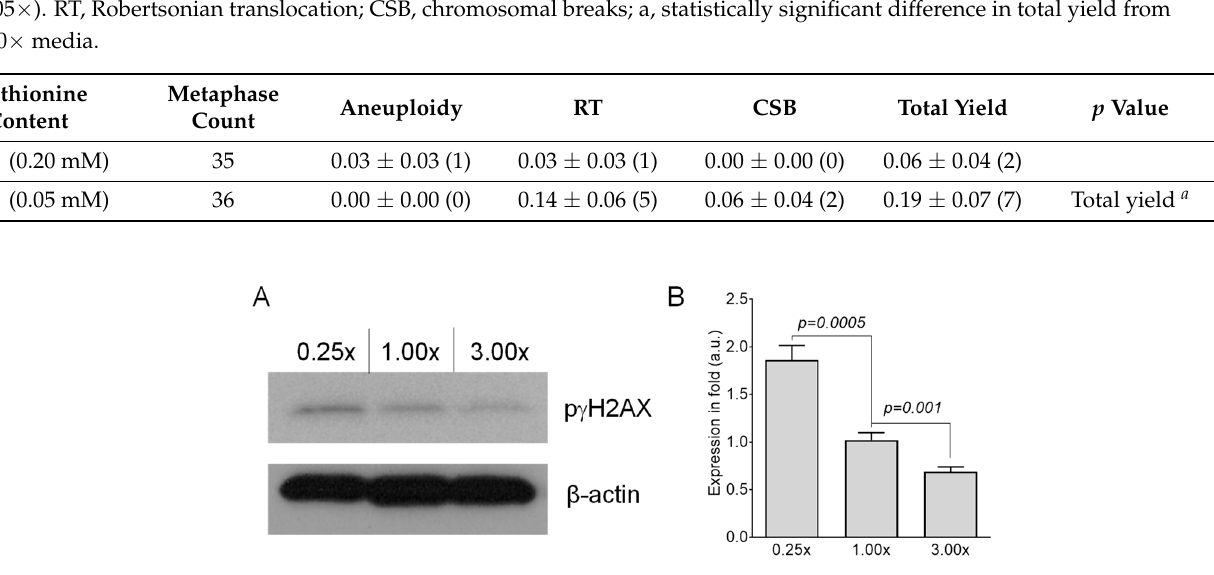
Figure 3. Effects of methionine on genetic damage. ( A ) Representative Western blot analysis and ( B ) quantitation of phosphorylated γ H2AX protein, a marker of DNA double-strand breaks, in RAW 264.7 cells grown in either methionine-deficient (0.25×) or adequate (1.00×) or supplemented (3.00×) media for 1 month ( n = 4). β -actin served as a loading control. n , number of independent experiments performed.